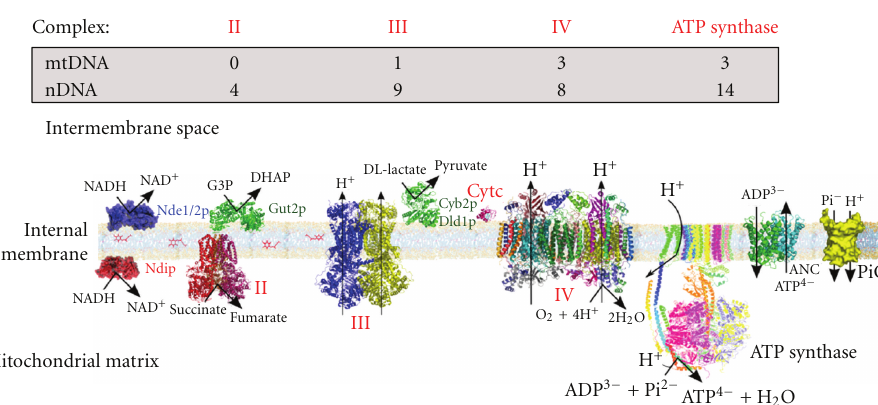
Figure 1: The mammalian oxidative phosphorylations (OXPHOS) system. Depicted are the four respiratory complexes (I–IV), electron carriers coenzyme Q and cytochrome c, the ATP synthase complex, the ADP/ATP carrier (ANC); and the phosphate carrier (PiC). Arrows at complexes I, III, and IV illustrate the proton pumping to the intermembrane space. Indicated are the number of complex subunits encoded by mitochondrial (mtDNA) and nuclear (nDNA) genomes.